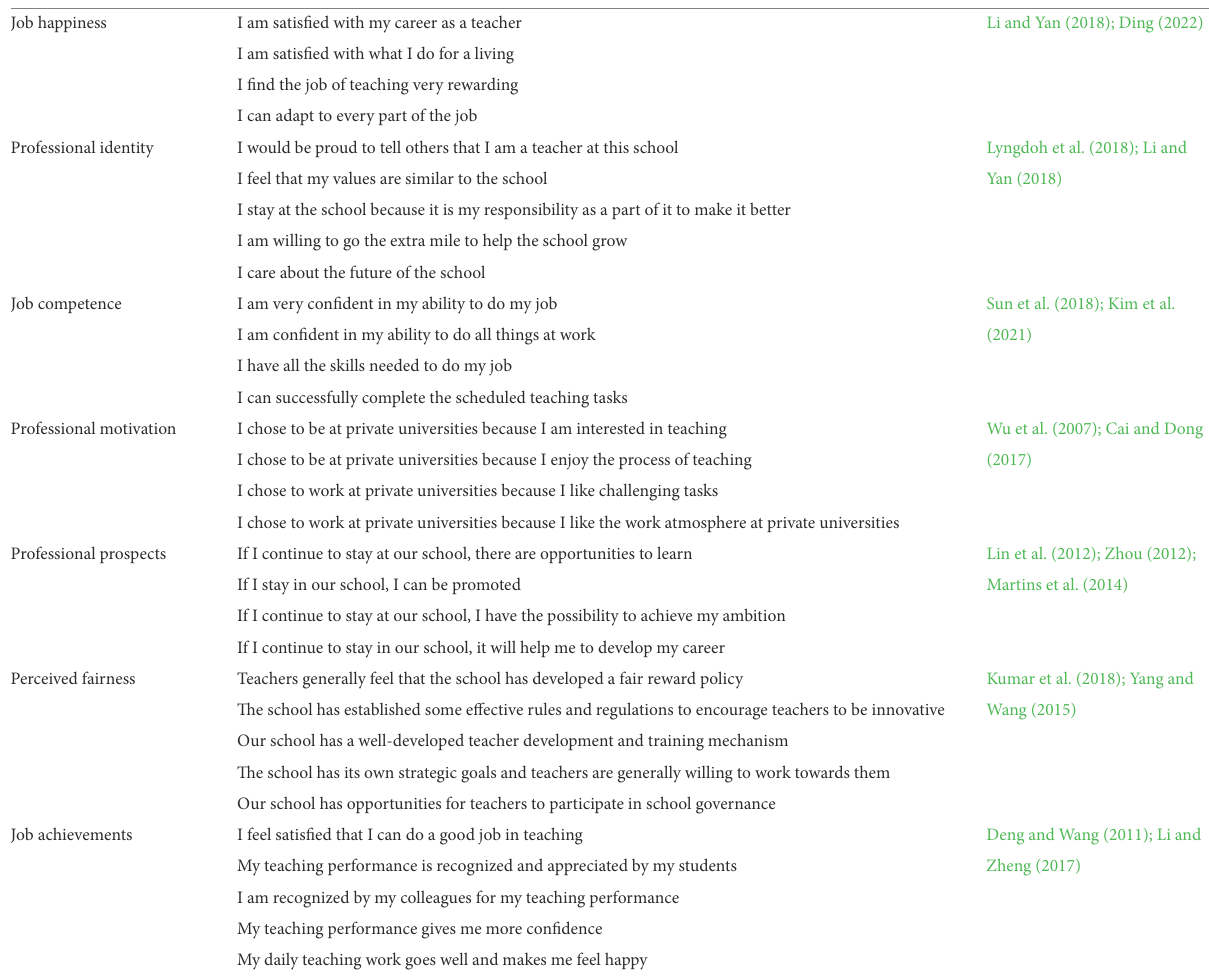
TABLE 1 Variable measurements and their